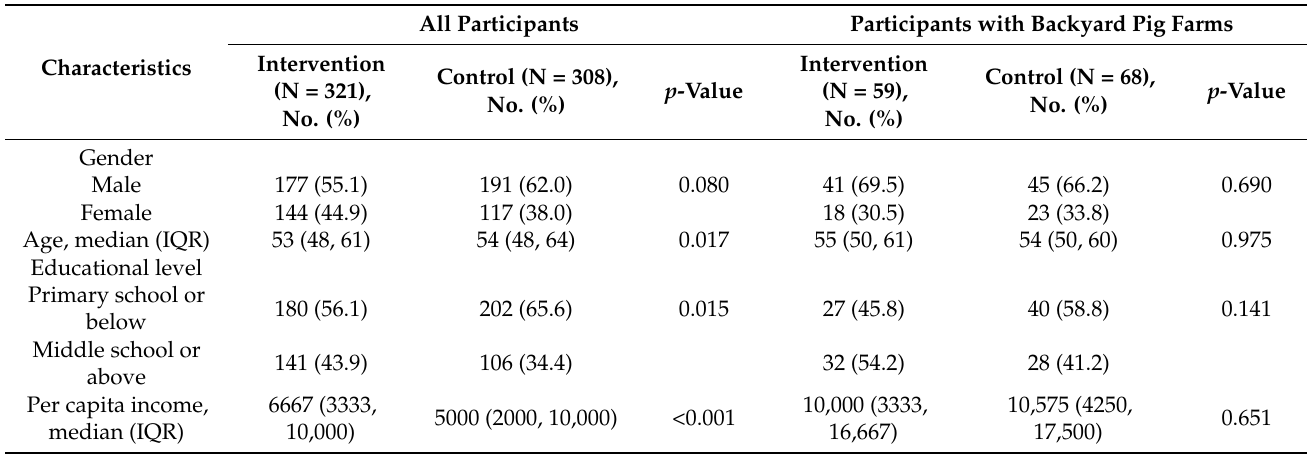
Table 1. Socio-demographic characteristics of the